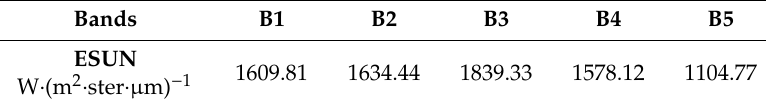
Table 3. Calculated ESUN values for all GF-4 bands.